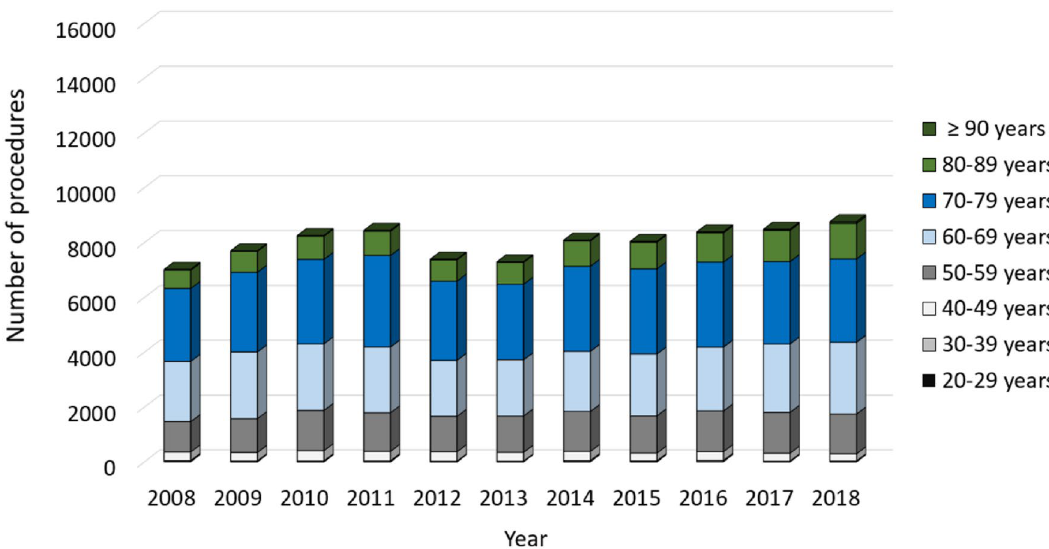
Figure 4. Revision knee arthroplasty procedures of male patients from 2008 through 2018 divided by age.